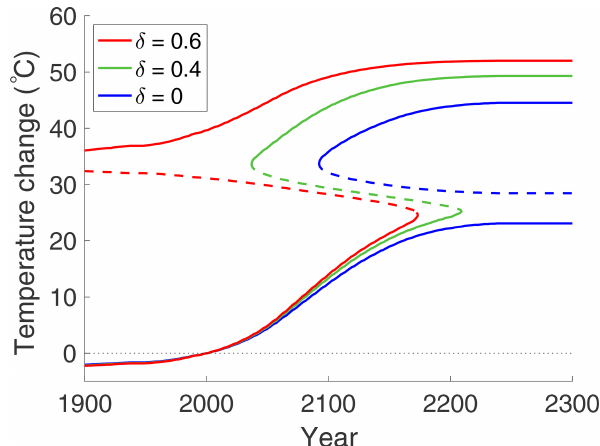
Figure 8. Arctic surface temperature change with increasing rela- tive humidity of water vapour, δ = 0 . 0, 0 . 4, 0 . 6, and with fixed F O and F A , projected to year 2300. (Temperature change is relative to the year 2000 temperature; see text for details.) On all three curves, CO 2 is increasing in time according to RCP 8.5. The red curve is essentially the same as that shown in Fig. 6 with δ = 0 . 6. The blue and green curves have water vapour fixed at δ = 0 . 0 and δ = 0 . 4, respectively. For temperatures significantly below freezing, water vapour makes little contribution to temperature change. However, above freezing (τ S > 1 ) , the greenhouse warming effect of water vapour is